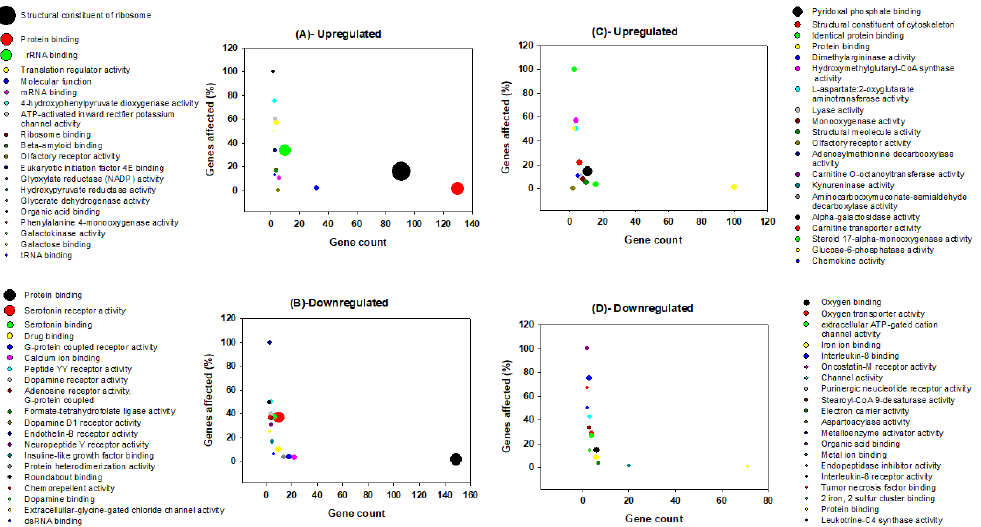
Figure 4. Graphical representation of molecular function terms for genes that are up-regulated in the brain ( A ), down-regulated in the brain ( B ), up-regulated in the liver ( C ), and down-regulated in the liver ( D ) following rapid eye movements sleep deprivation in rats. The x -axis shows gene count, and the y -axis shows the percentage of genes a ff ected. The bubble size represents the log transformed p -value [Y = − 0.5*log(Y)] of the respective molecular function. A bigger bubble size indicates a more significantly a ff ected given process, and thus, a lower p -value. The top 20 terms are displayed for each category.